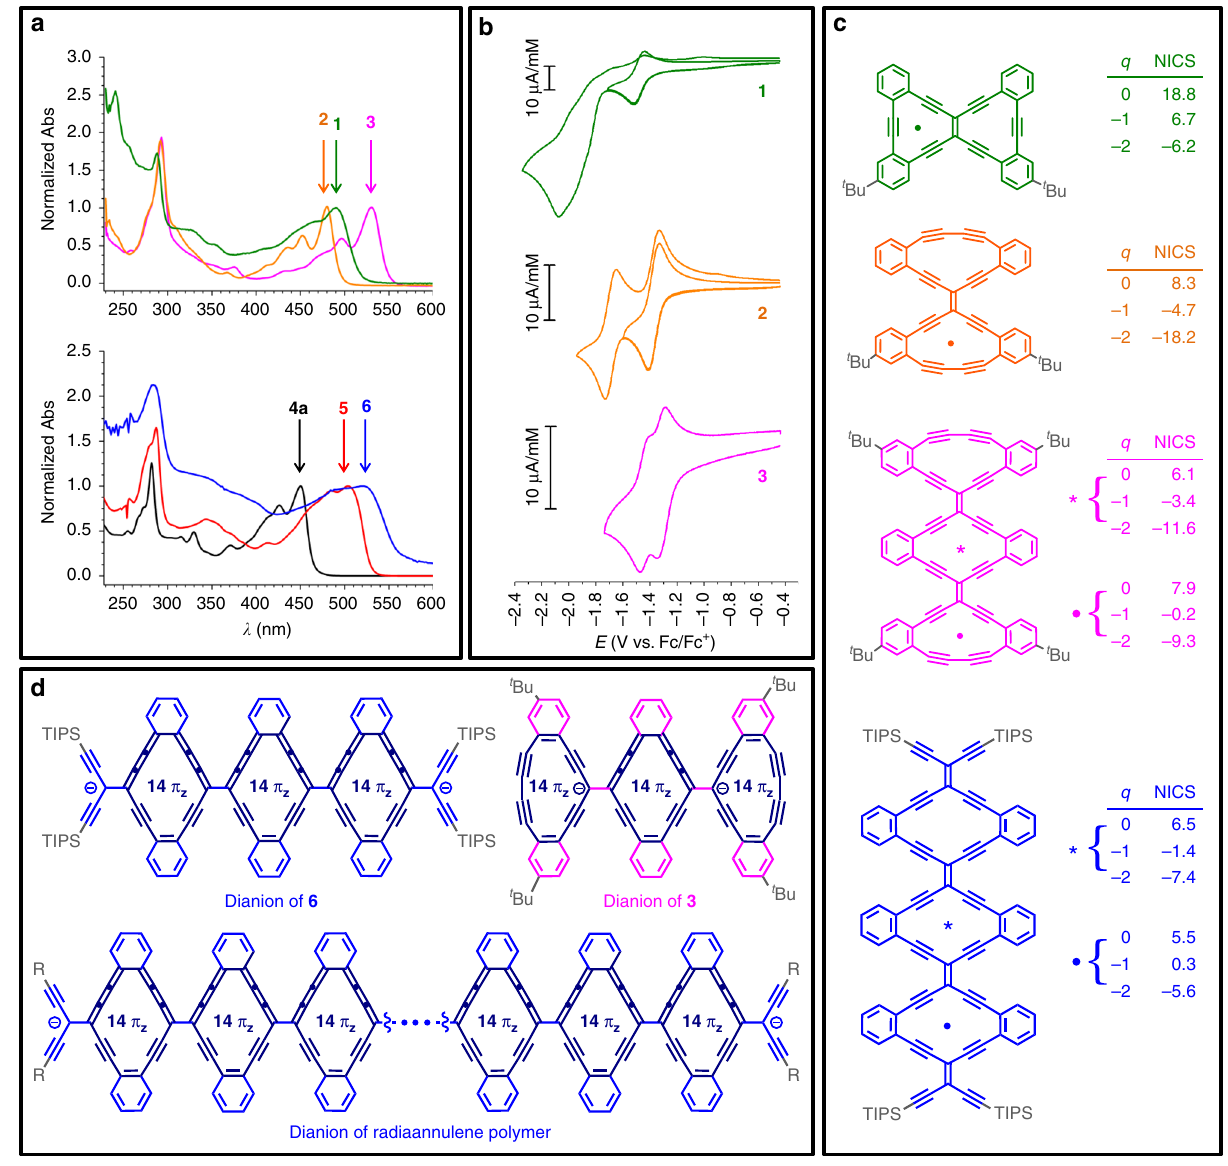
Fig. 5 Properties of the compounds. a Electronic absorption spectra of 1 (green line), 2 (orange line), and 3 (pink line) in CH 2 Cl 2 and of 4a (black line), 5 (red line), and 6 (blue line) in THF. The spectra were normalized based on the longest-wavelength absorption maximum (note, the broadening and tailing of the low energy absorption of 6 could arise from impurities, see the text for additional discussion). b Cyclic voltammograms of 1 (green line), 2 (orange line), and 3 (pink line) in CH 2 Cl 2 ( + 0.1 M Bu 4 NPF 6 ); scan rate 0.1 V s − 1 . Fc = ferrocene. c Nucleus independent chemical shift, NICS(1) π zz , values calculated for different charge states ( q ) at 1 Å above the center of the rings marked by a solid circle and a star (B3LYP/cc-pvdz; t Bu and TIPS groups have been replaced by hydrogen atoms). d Canonical forms of the dianions of trimers 3 , 6 , and of an in fi nite radiaannulene graphyne nanoribbon (GyNR). t Bu =